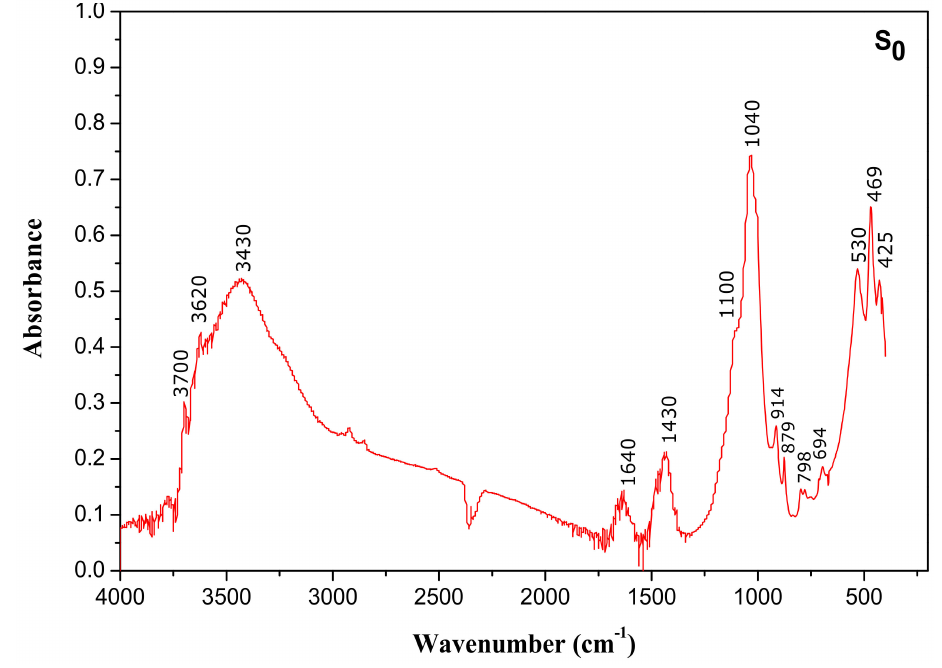
Figure 5. Fourier transform infrared (FTIR) spectrum of raw material ( S 0